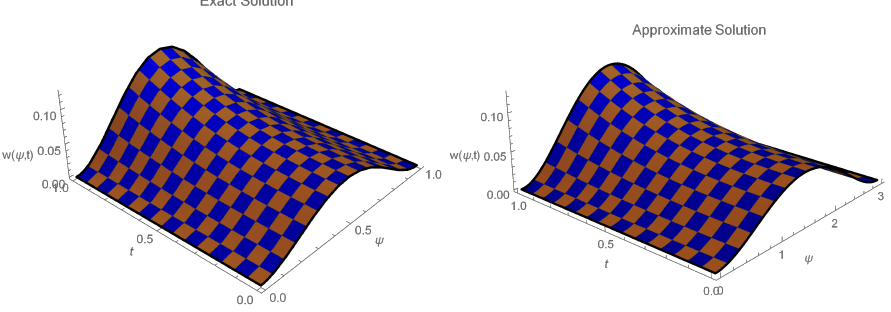
Figure 8. Three-dimensional space–time analytic and approximate solutions of Example 2 obtained by the proposed scheme when γ = 0.001, ˜ M = K = 80.